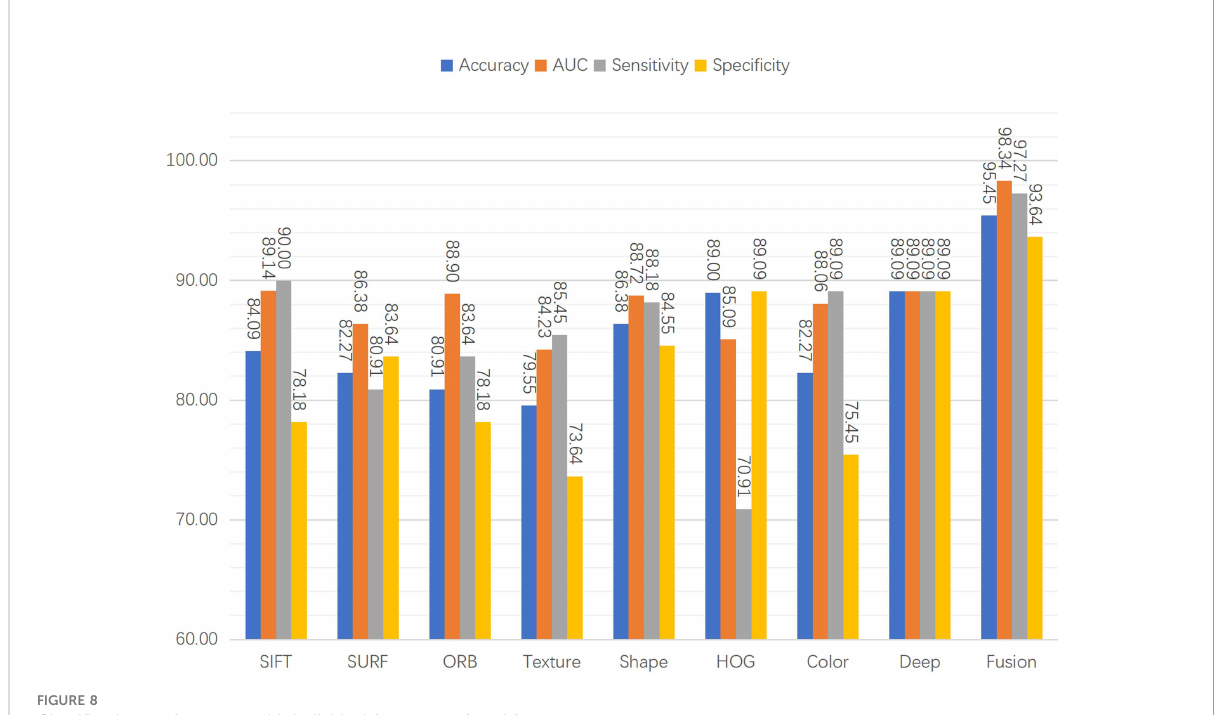
FIGURE 8 Classi fi cation performance with individual features or fused features.